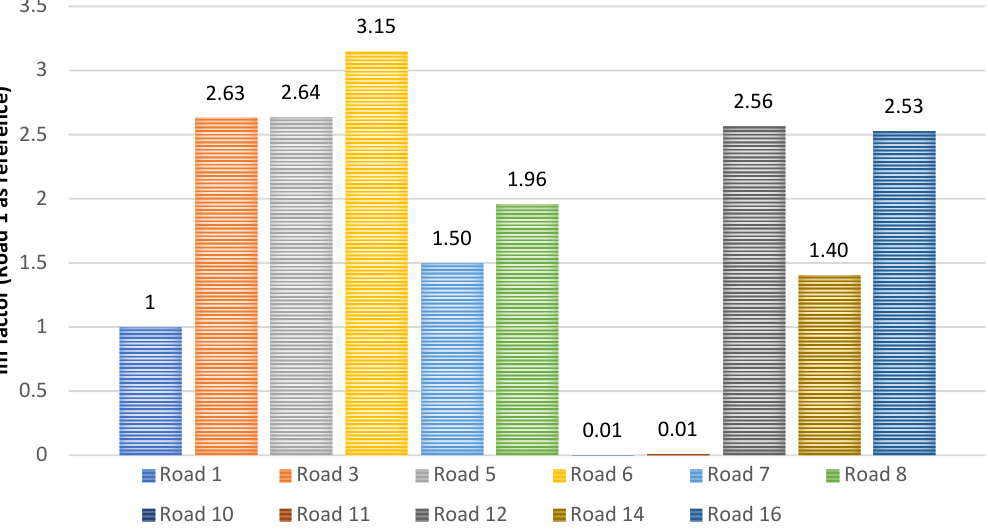
Figure 11. Vertical loads of the unsprung mass (simultaneous deflection of parabolic springs).